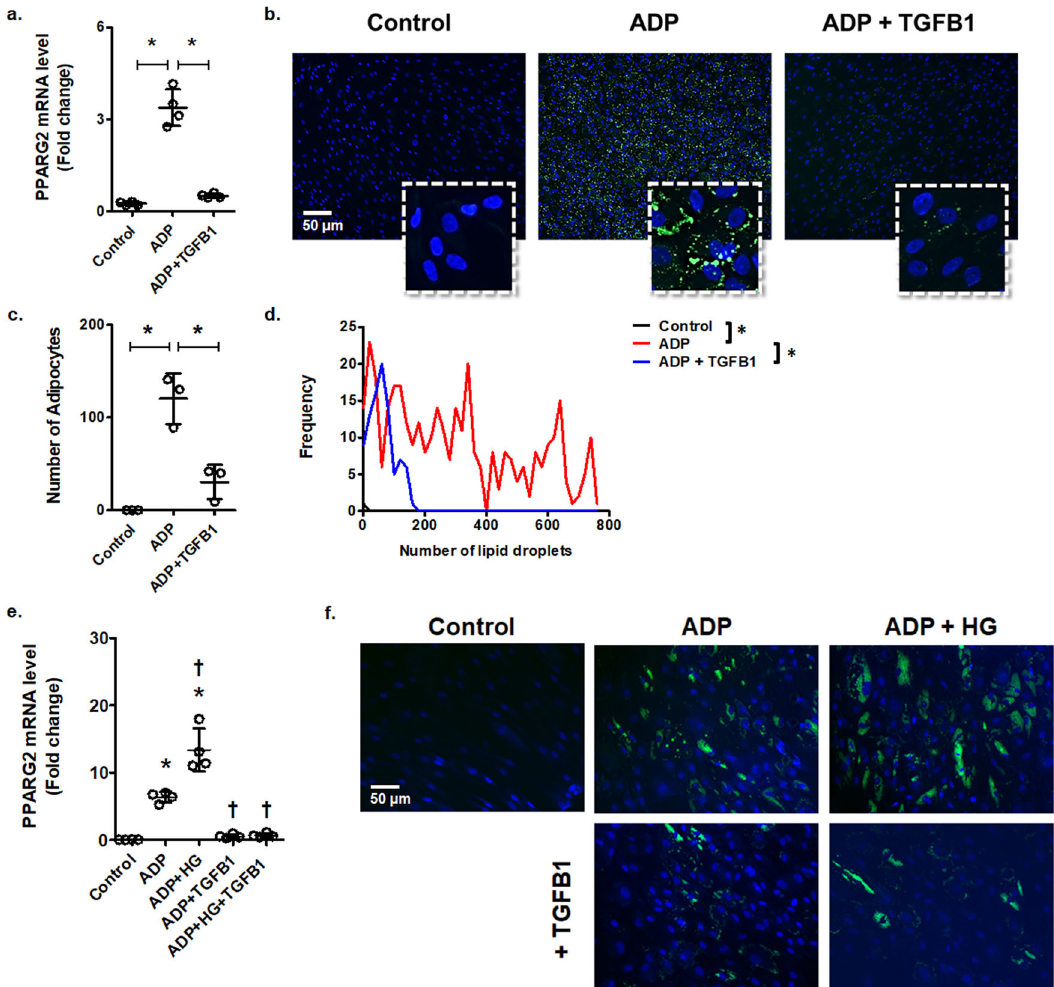
Fig. 5 TGFB1 exposure inhibits adipogenic differentiation of bone marrow mesenchymal progenitor cells. Human bone marrow-derived progenitor cells (bm-MPCs) were induced to differentiate in an adipogenesis-inducing media (ADP), with or without TGFB1 (10 ng/mL) for 72 h. a mRNA levels of PPARG2 in bm-MPCs [Data normalized to ACTB , GAPDH , and RPLP0; Mean± SD; n = 4; each data point represents an independent sample; ANOVA followed by Bonferroni post hoc analysis: * p < 0.05]. b bm-MPCs, treated as indicated in panel a , were stained with LipidTOX (green) to detect intracellular lipid accumulation. Cells were counterstained with DAPI (blue) [scale bar = 50 μ m]. Inserts showing higher magni fi cation. The number of adipocytes and frequency of lipid droplets were measured by CellPro fi ler [Mean± SD; n = 3 for panel c , 3 images per replicate were measured for panel d ; ANOVA followed by Bonferroni post hoc analysis: * p < 0.05]. e bm-MPCs were cultured in control, adipogenic media (ADP), or ADP supplemented with TGFB1 (10 ng/mL) or high glucose (HG; 25 mmol/L) for 7 days. mRNA levels of PPARG2 were measured [Data normalized to ACTB; Mean ± SD; n = 4; each data point represents an independent sample; ANOVA followed by Bonferroni post hoc analysis: * p < 0.05 compared with control, † p < 0.05 compared with ADP]. f Detection of intracellular lipid accumulation in bm-MPCs by LipidTOX (green) staining. Cells were counterstained with DAPI (blue) [scale bar = 50 μ m]. Cells were treated as indicated in Panel e